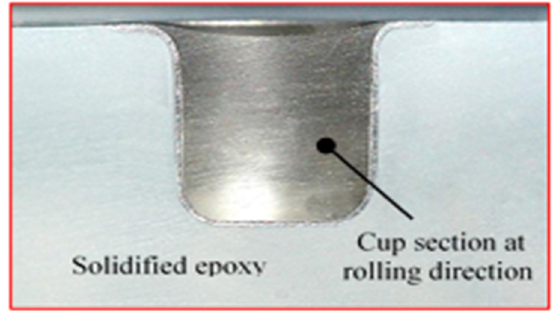
Fig. 11. Section of epoxy material and metallic